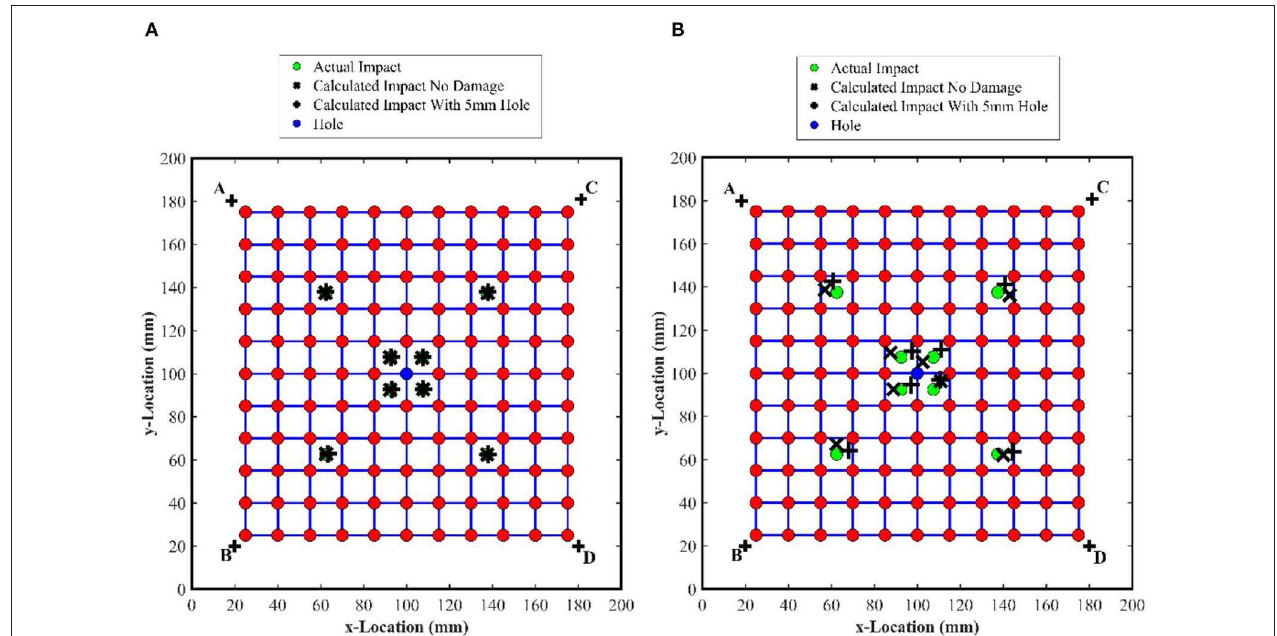
FIGURE 9 | The CoG method (A) and the MA approach (B) applied to TR with no grid refinement in the damaged plate.